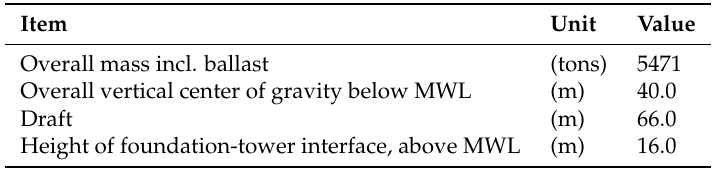
Table 3. Overall properties of the global